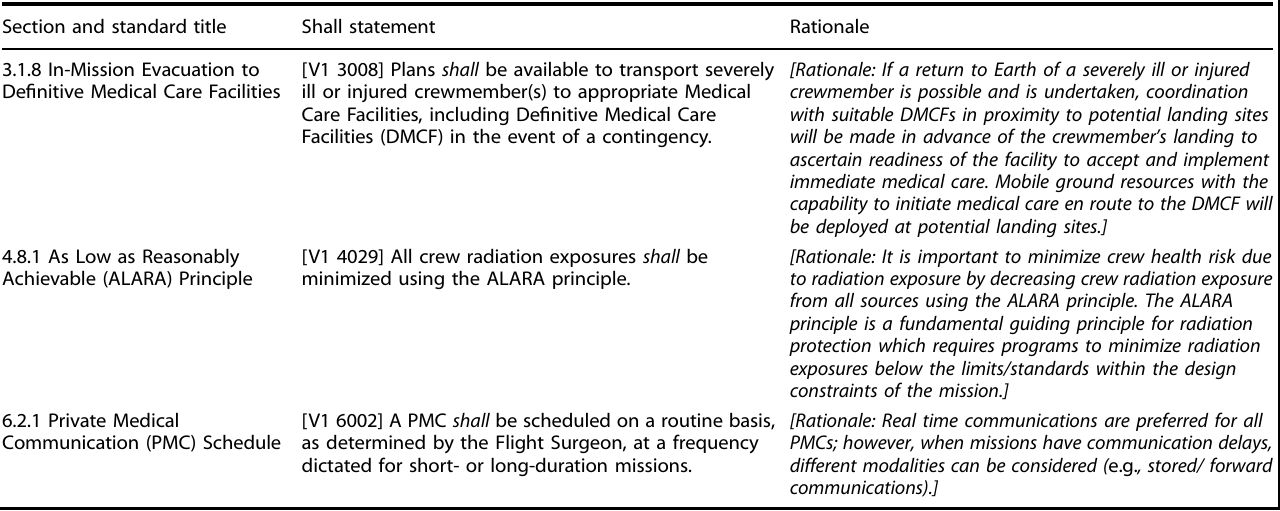
Table 1. Selected examples of technical requirements from NASA-STD-3001 volume 1. Section and standard title